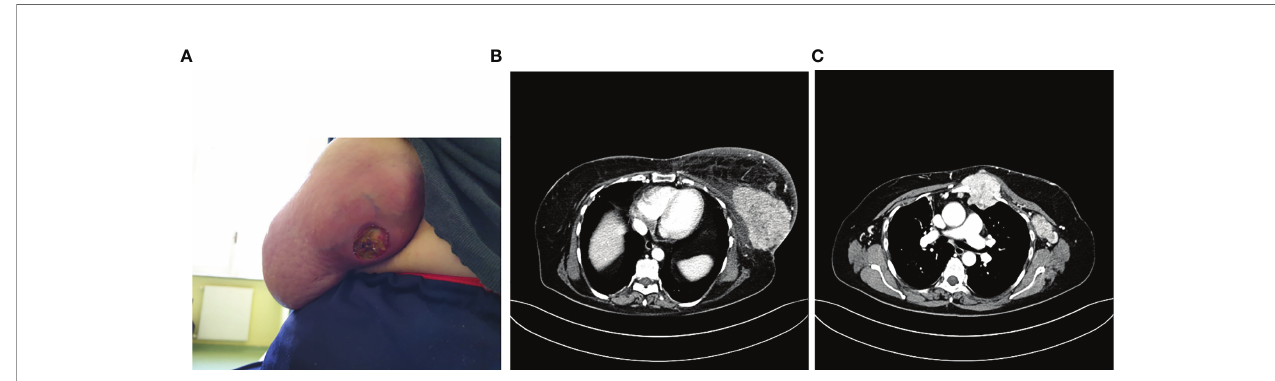
FIGURE 1 | Photo of the ulcerated swelling at the level of the external quadrants of the left breast (A) , described also at the CT scan (B) with the involvement of locoregional lymph nodes and sternum